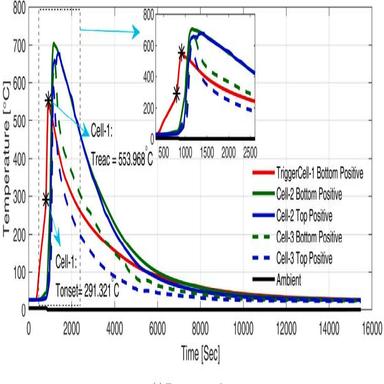
Overheating test of battery module with ceramifiable silicone rubber (1.5 mm + 0.3 mm) thermal barriers.